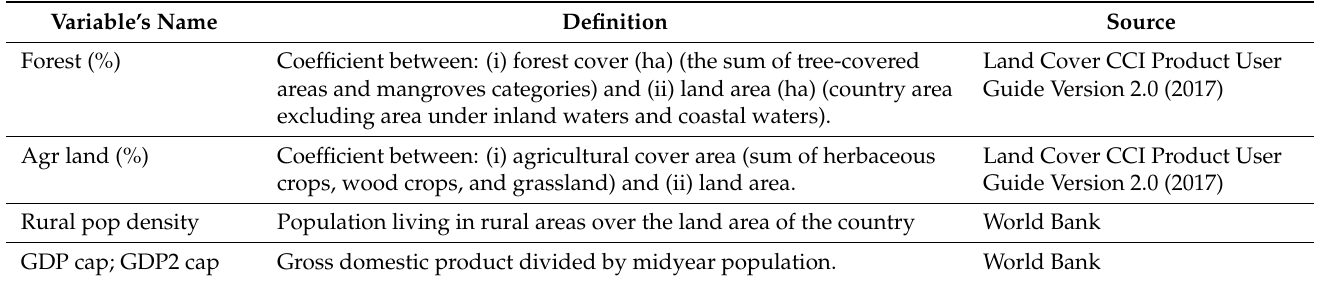
Table 3. Summary of variables.